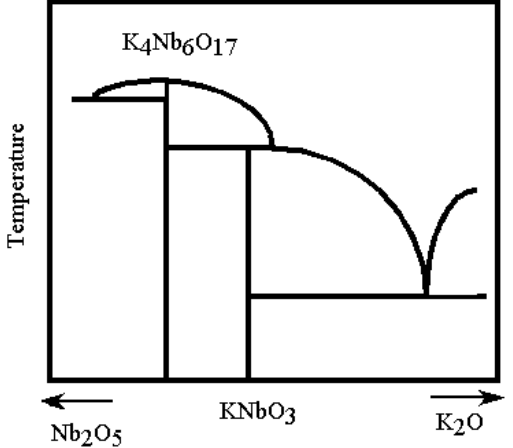
, reprinted with permission from 3